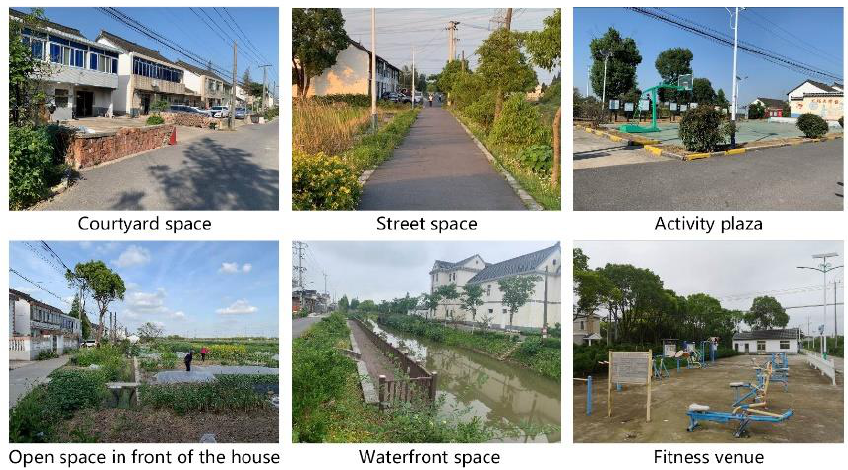
Figure 2. Types of rural outdoor activity spaces.